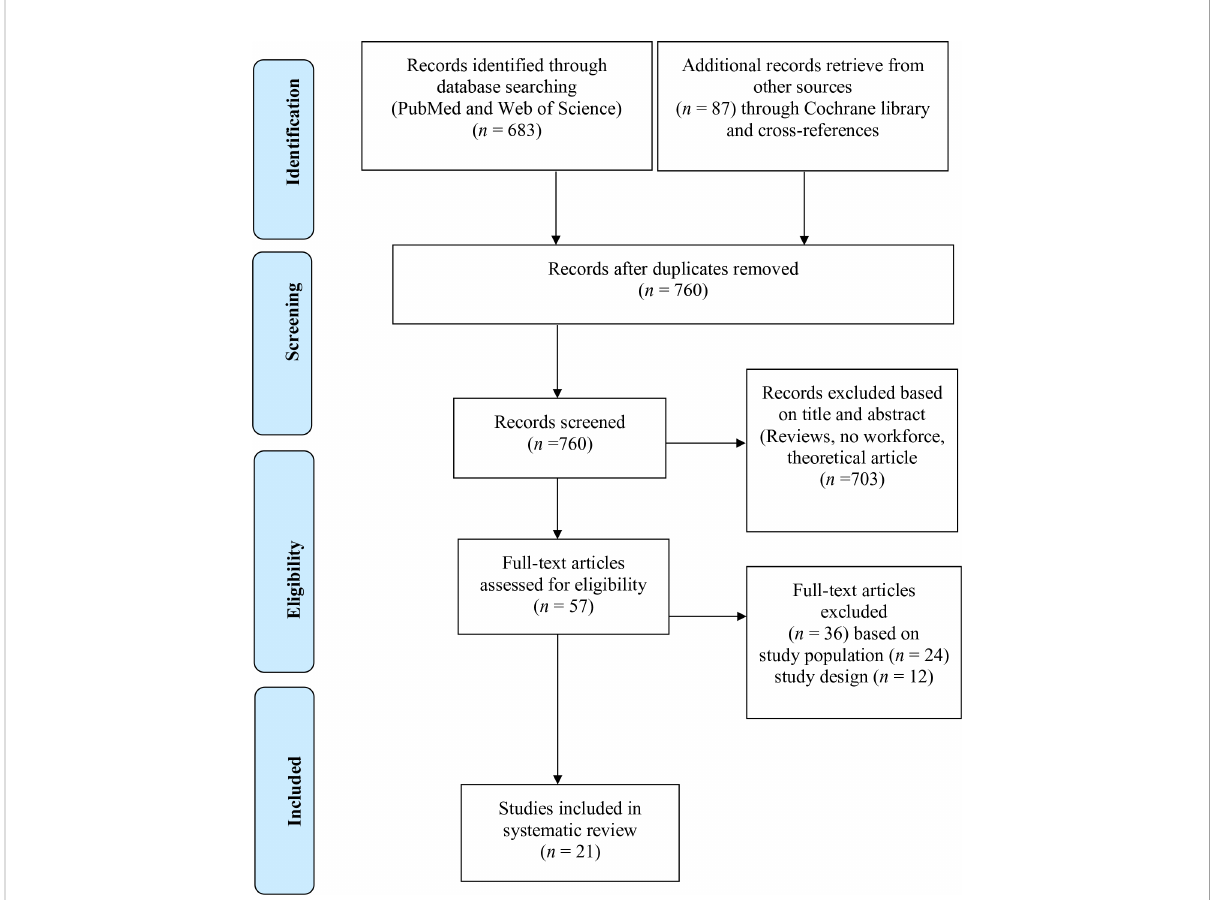
FIGURE 1 PRISMA fl ow diagram of search